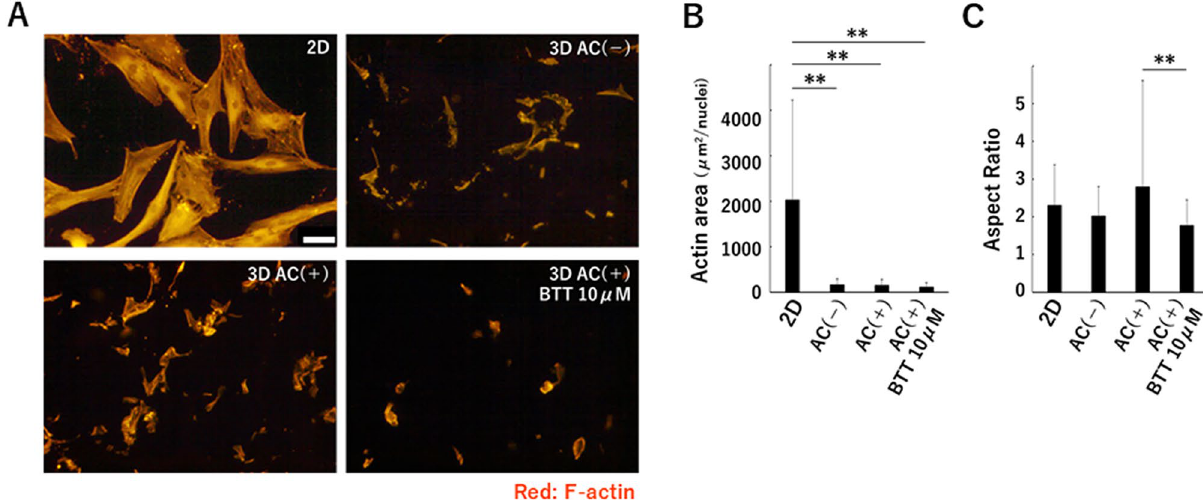
Figure 6. BTT 3033 alters the cell shape in the AC(+) group. ( A ) Visualization of actin filament in the cells of the 2D group, the AC(−) without BTT 3033 group, the AC(+) without BTT 3033 group, and the AC(+) with BTT 3033 group using fluorescent phalloidin. ( B , C ) To quantify the effect of BTT 3033 on cell shape, the cellular area ( B ) and aspect ratio ( C ) were calculated as described in the Materials and Methods. Scale bar: 50 μm. * p < 0.05, ** p <